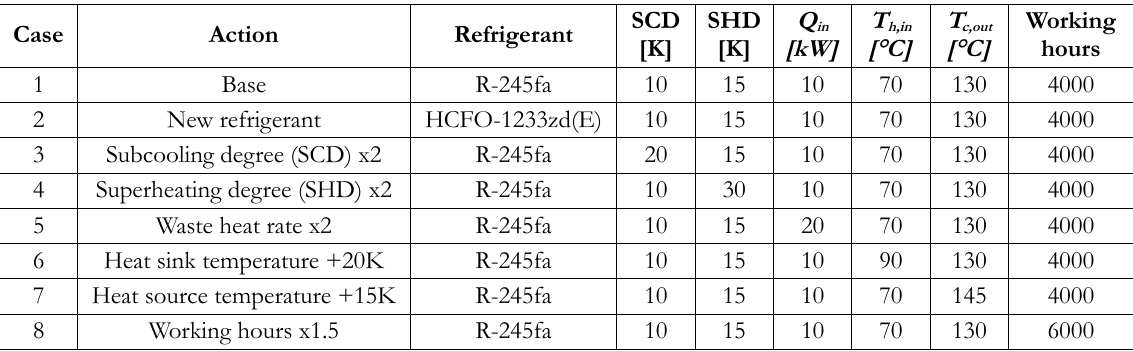
Table 3. Proposed conditions for the simulation and practice with the HeatPack software